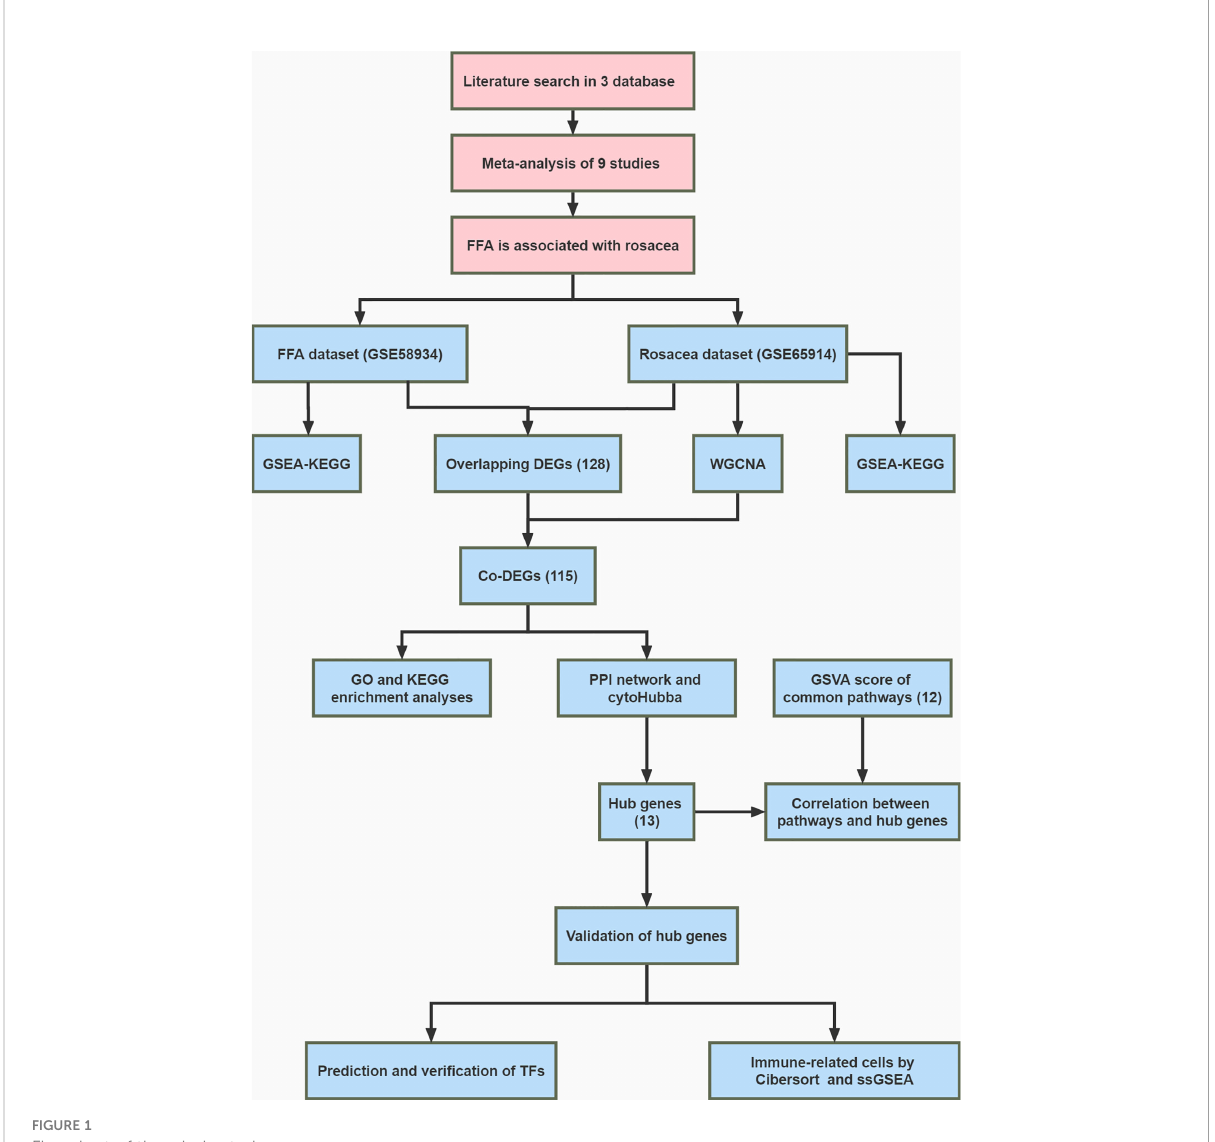
FIGURE 1 Flowchart of the whole